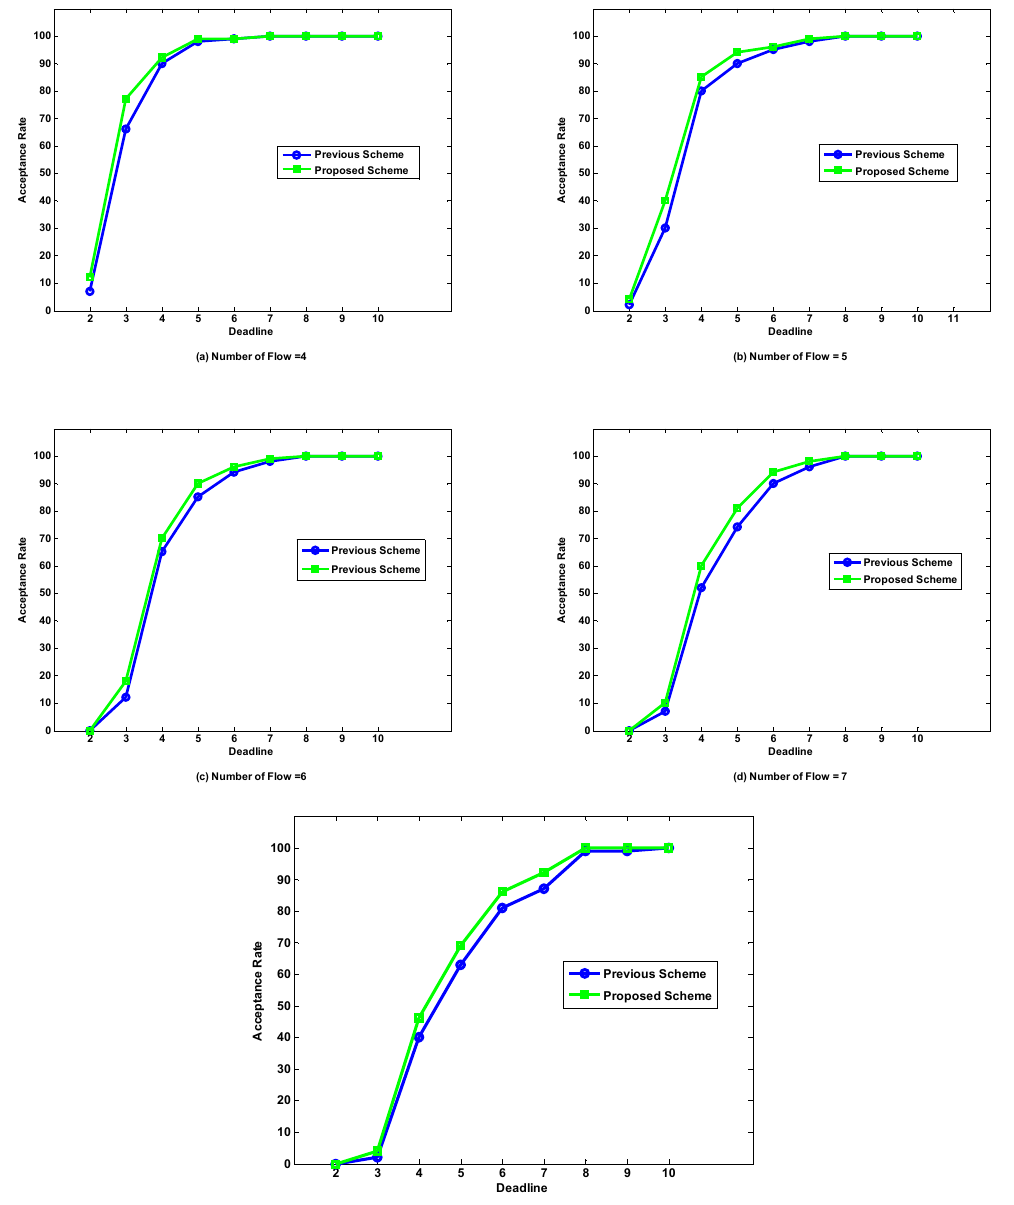
Figure 5. Simulation results w.r.t flows .